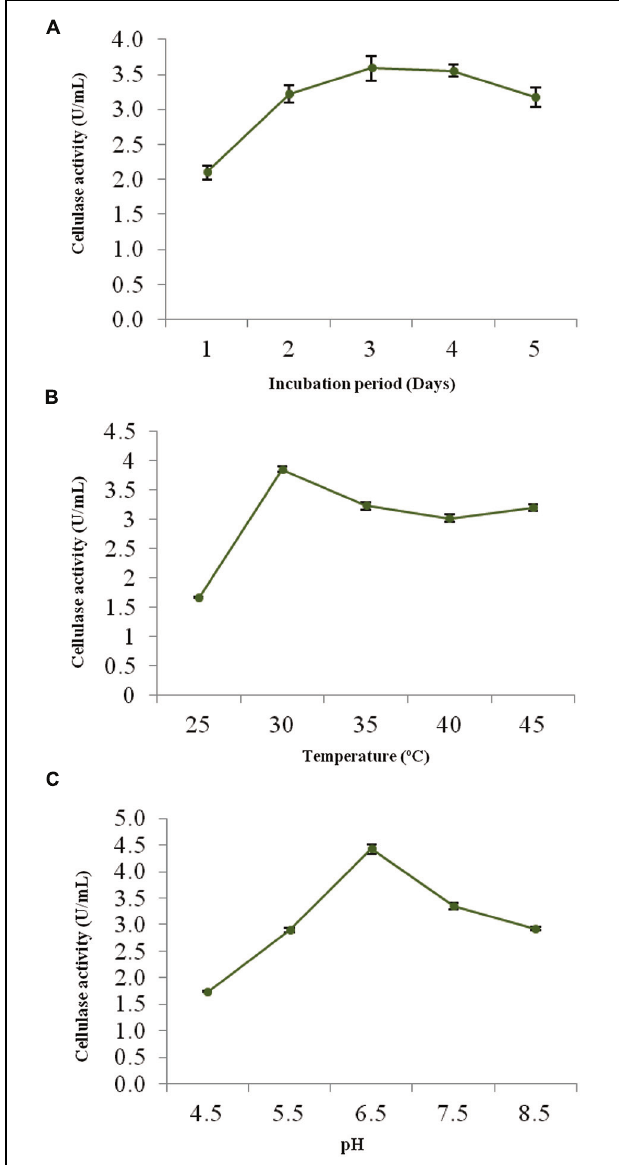
FIGURE 2 | Effects of process parameters on CMCase activity of Enhydrobacter sp. ACCA2. The strain ACCA2 was cultured under different incubation times (A) , temperature (B) and initial pH (C) , and CMCase activity was assayed in triplicates. The presented values are the mean and standard